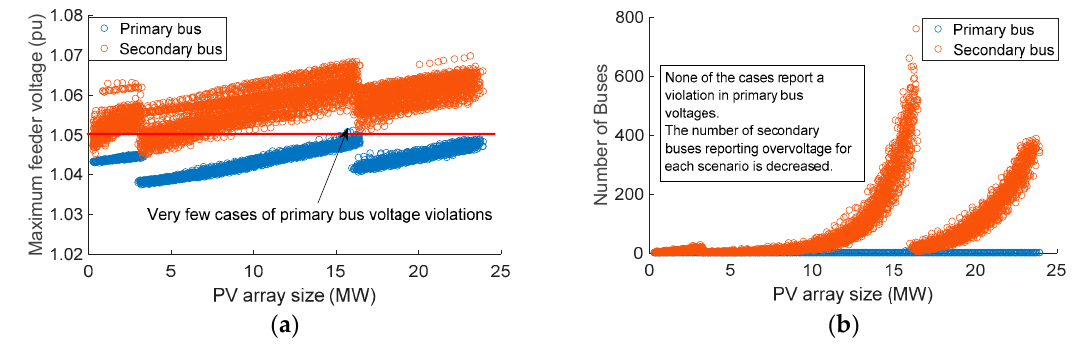
Figure 6. Load tap changers (LTC) and capacitor control: ( a ) Largest feeder voltages; ( b ) Number of bus voltage violations.